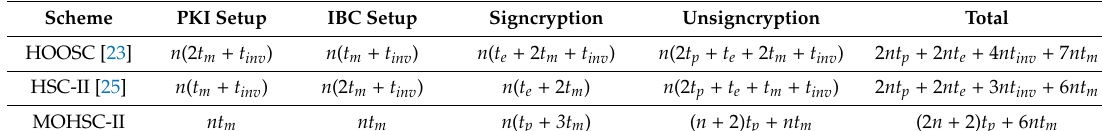
Table 3. Computation comparisons (IBC → PKI).